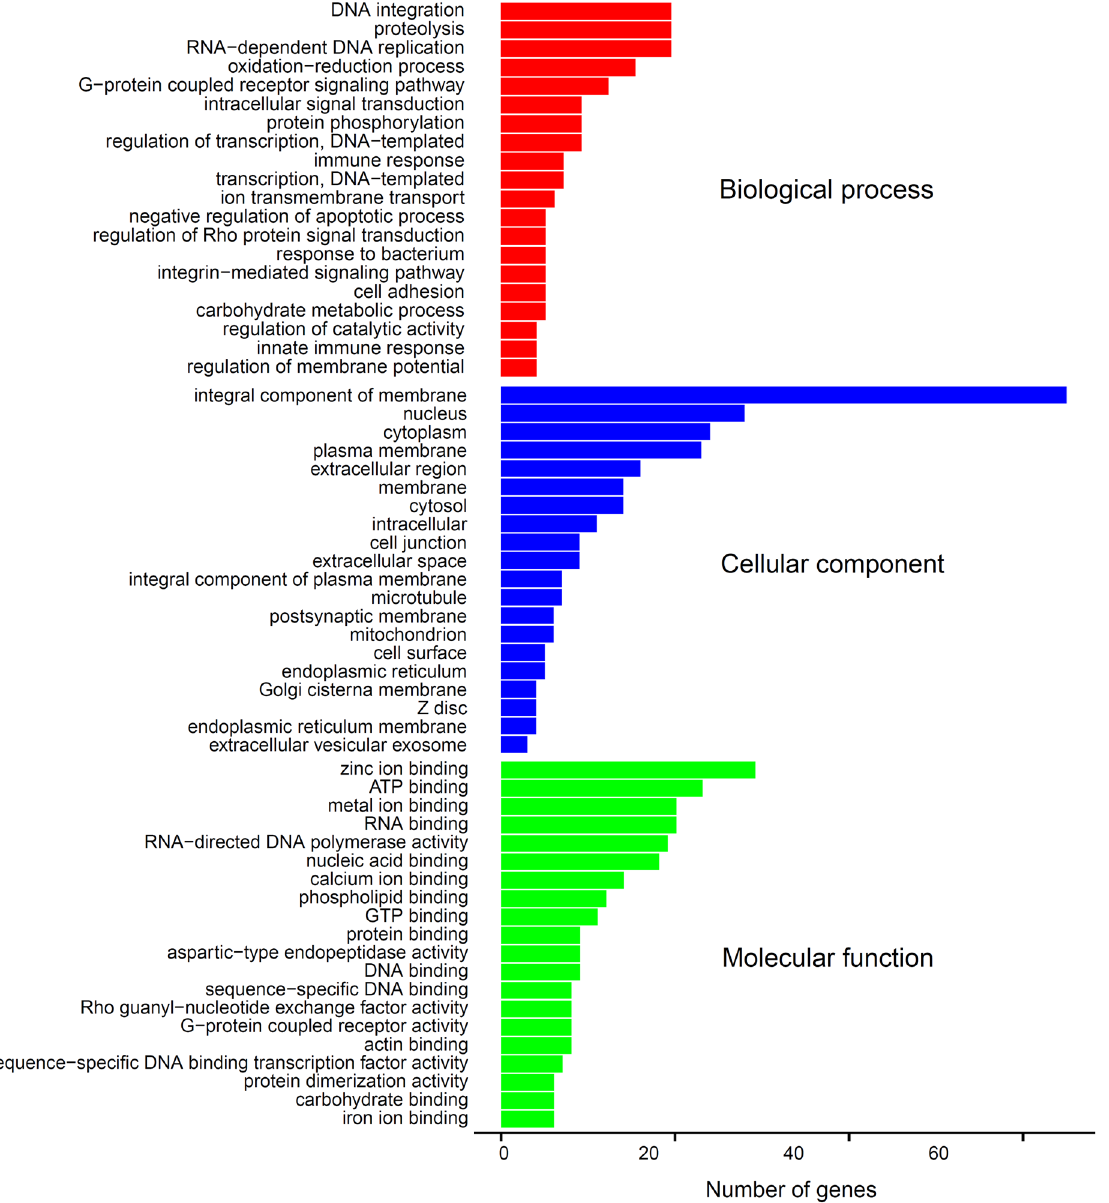
Fig 3. Functional classification of the DEGs that has higher expression in YY than XY based on gene ontology (GO) terms: biological process (red), cellular component (blue),molecular function (green). The X-axis is number of unigenes.